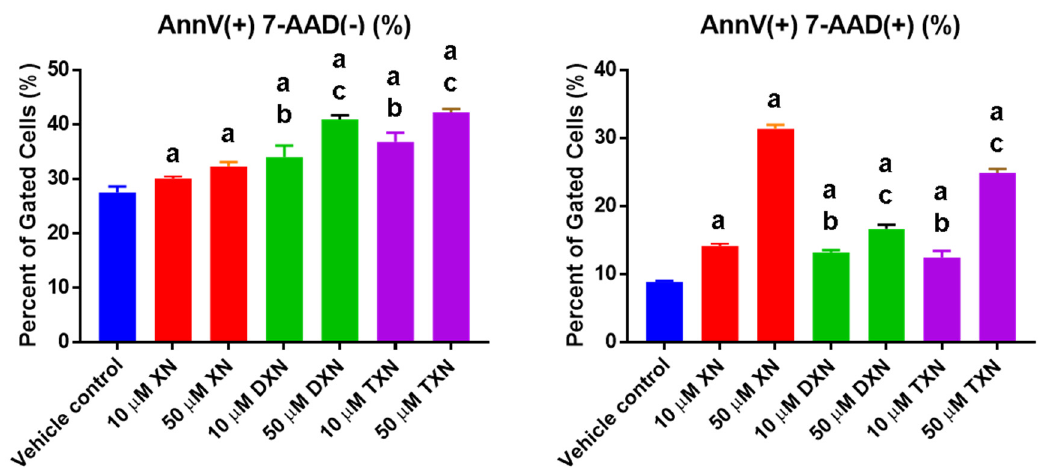
Figure 2. XN, DXN, and TXN induce apoptosis in HT29 cells. Cells were treated with each prenylated flavonoid at the concentration indicated (10 or 50 µ M), and apoptosis was detected using an Annexin V assay. Externalization of phosphatidyl serine, an early marker of apoptosis, was detected by flow cytometry after staining with Annexin V-PE and 7-AAD. Annexin V( + ) 7-AAD( − ) cells are undergoing early apoptosis ( left panel ), and Annexin V( + ) 7-AAD( + ) are undergoing late apoptosis ( right panel ). Values are mean ± SD, n = 9 for each treatment. The letter “a” indicates a statistically significant difference from vehicle control, the letter “b” indicates a statistically significant difference from 10 µ M XN, and the letter “c” indicates a statistically significant difference from 50 µ M XN ( p < 0.05). Statistical analysis was performed using one-way ANOVA with a Sidak’s post hoc test.